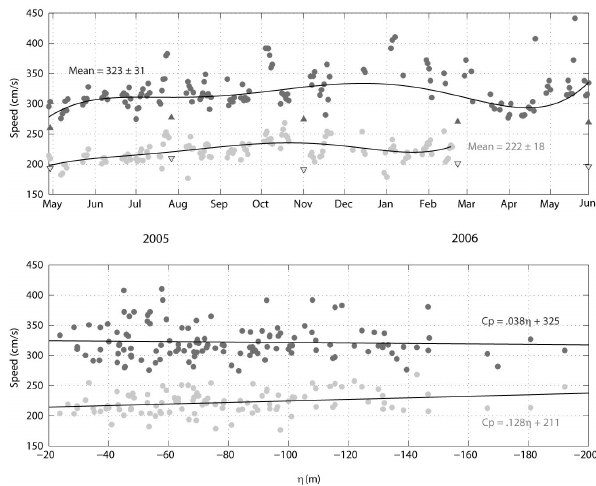
Fig. 5. Observed and computed propagation speeds of the nonlinear waves as a function of (a) time and (b) non-linear wave amplitude (positive downward). The observed propagation speeds were computed by tracking the waves between moorings B2 and B1 (black dots) and B1 and S7 (gray dots). The heavy black and gray lines in the upper panel show the 6th order polynomial fit to the data. The mean values and standard deviations are also shown. The theoretical mode-1 linear phase speeds (triangles) were computed from the CTD data as described in the